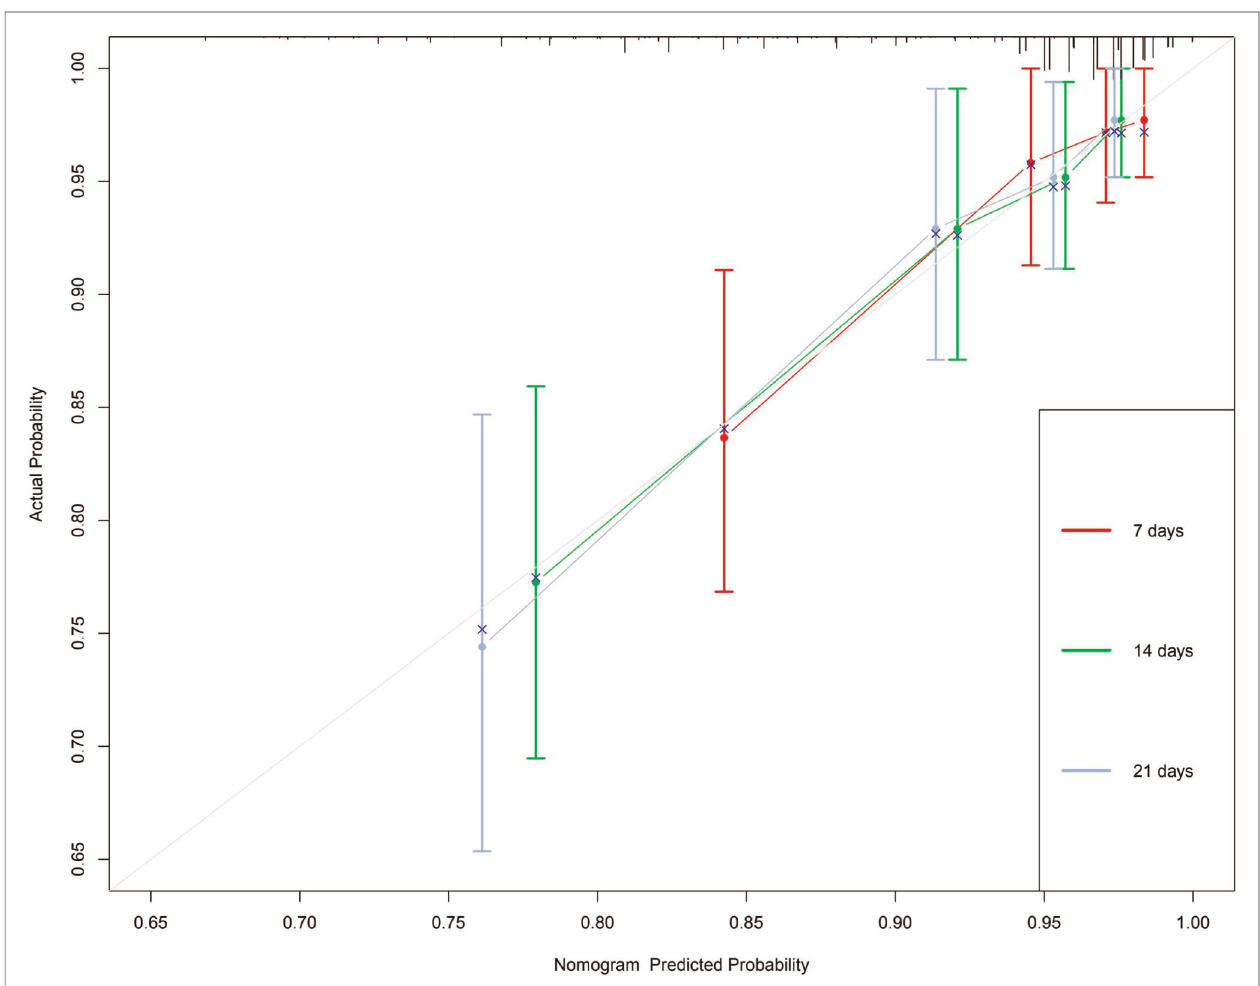
FIGURE 2 | 7-, 14-and 21-day calibration curve of nomogram. X -axis refers to probability of DCI and the y -axis means actual probability. The lines represent the perfect calibration models in which the predicted probabilities are identical to the actual